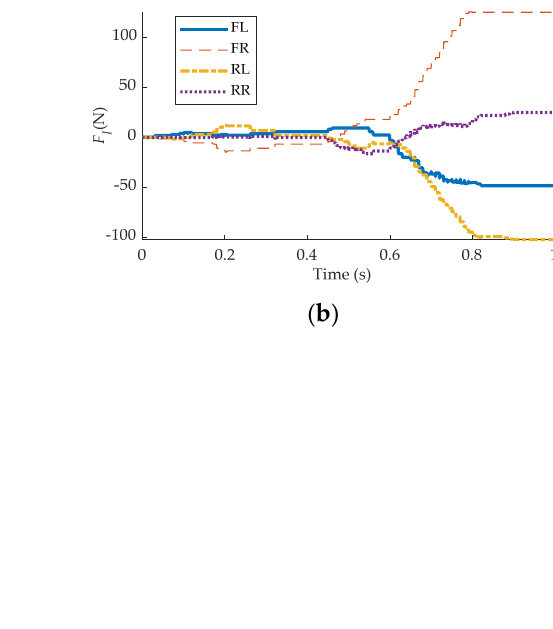
shown in Figure 6c.